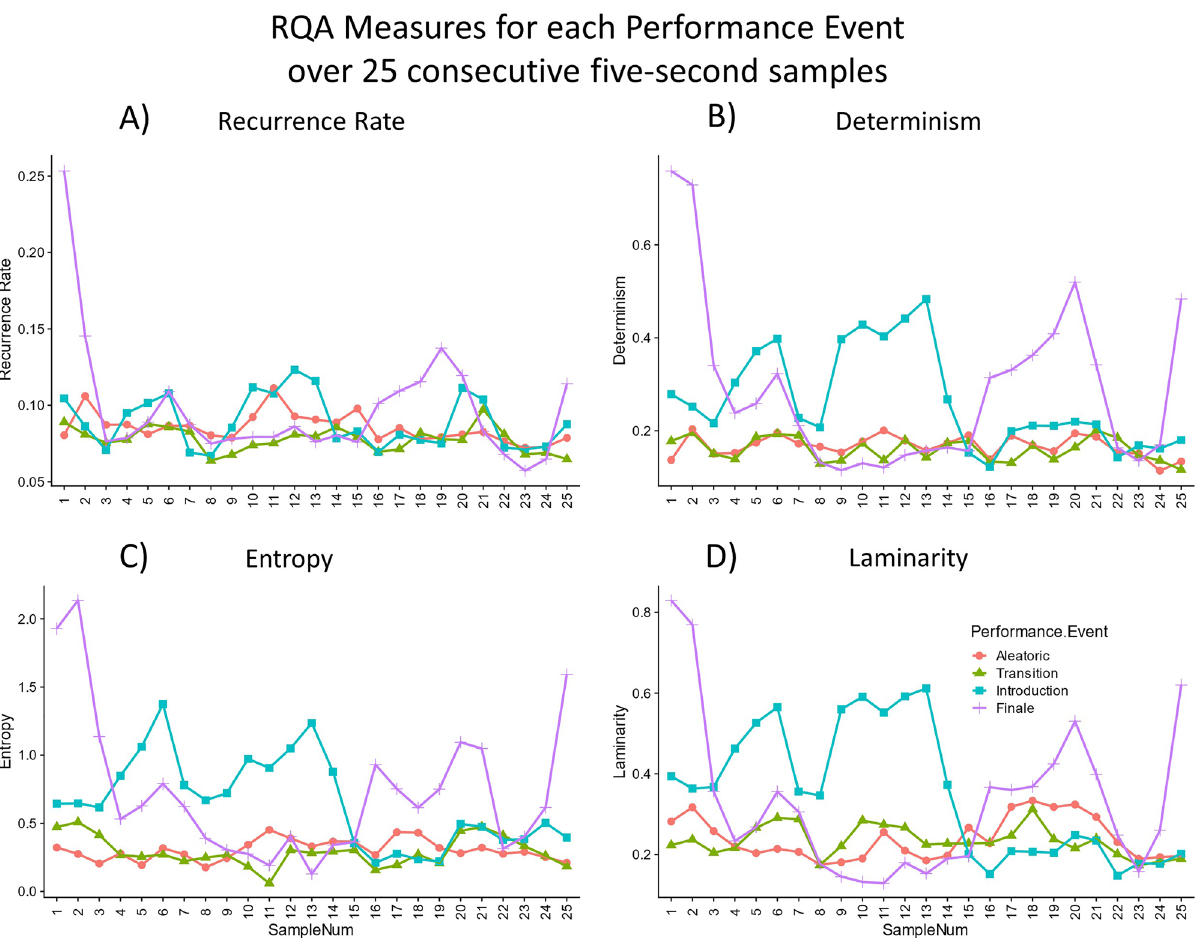
Figure 4. Serial plots visualizing the trajectories of recurrence behaviors over time. ( A ) Coordinated Performance Events (Introduction and Finale) show increased recurrent points overall (Recurrence Rate) compared with Uncoordinated Performance Events (Aleatoric and Transition). ( B ) Emerging presence of longer sequences of behavior as represented by higher levels of Determinism, and ( C ) higher levels of Entropy in Coordinated Performance Events, indicating more variability in sequence length. ( D ) Increased values of Laminarity in Coordinated Performance Events indicate enhanced stability in the system. The intermittency of these stable periods in the Coordinated Performance Events as shown in the recurrence plots (Figs. 1 and 2) can also be seen in the varying high and low values of Laminarity over time in the serial plots. Note: 9 s of audience applause during the Introduction Performance Event were not analyzed, and are subsequently excluded from all data